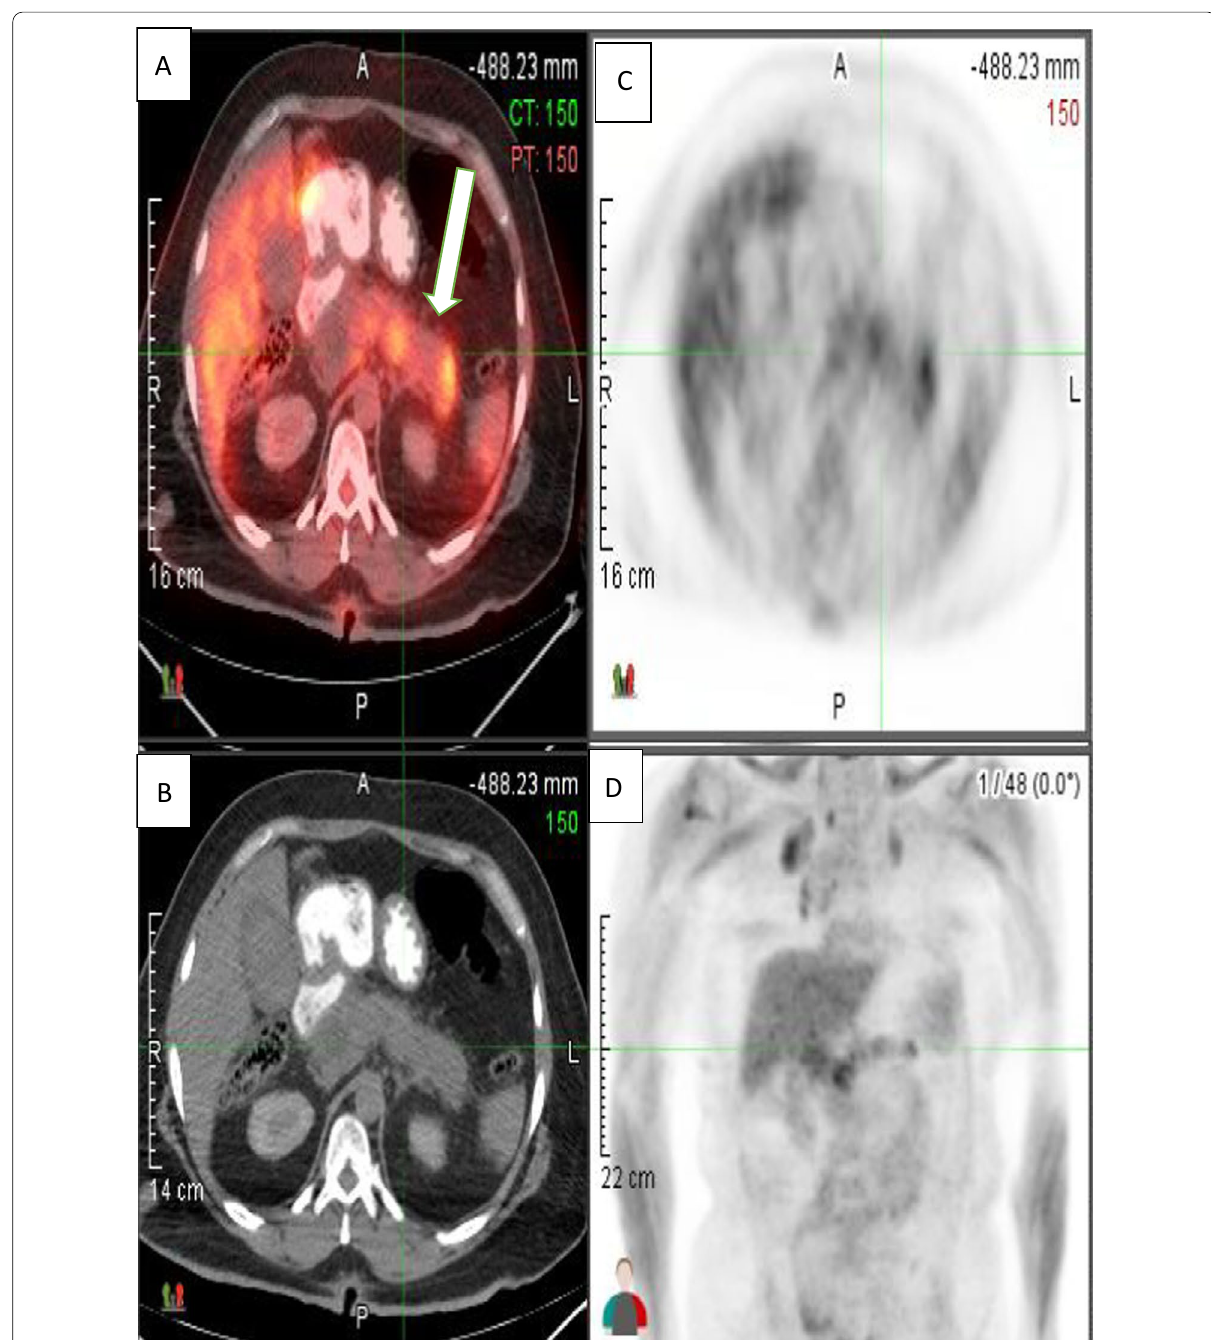
Fig. 3 65-year-old male patient with two avid FDG activity lesions in the body and tail of the pancreas, measuring 2 respectively with SUVmax 2.8(white block arrow) G1 PNET, which is histopathologically proved. There is infiltration of the fat surrounding the pancreatic body and tail, revealed neoplastic involvement. A Fused Axial PET/CT, B Axial CT, C , D